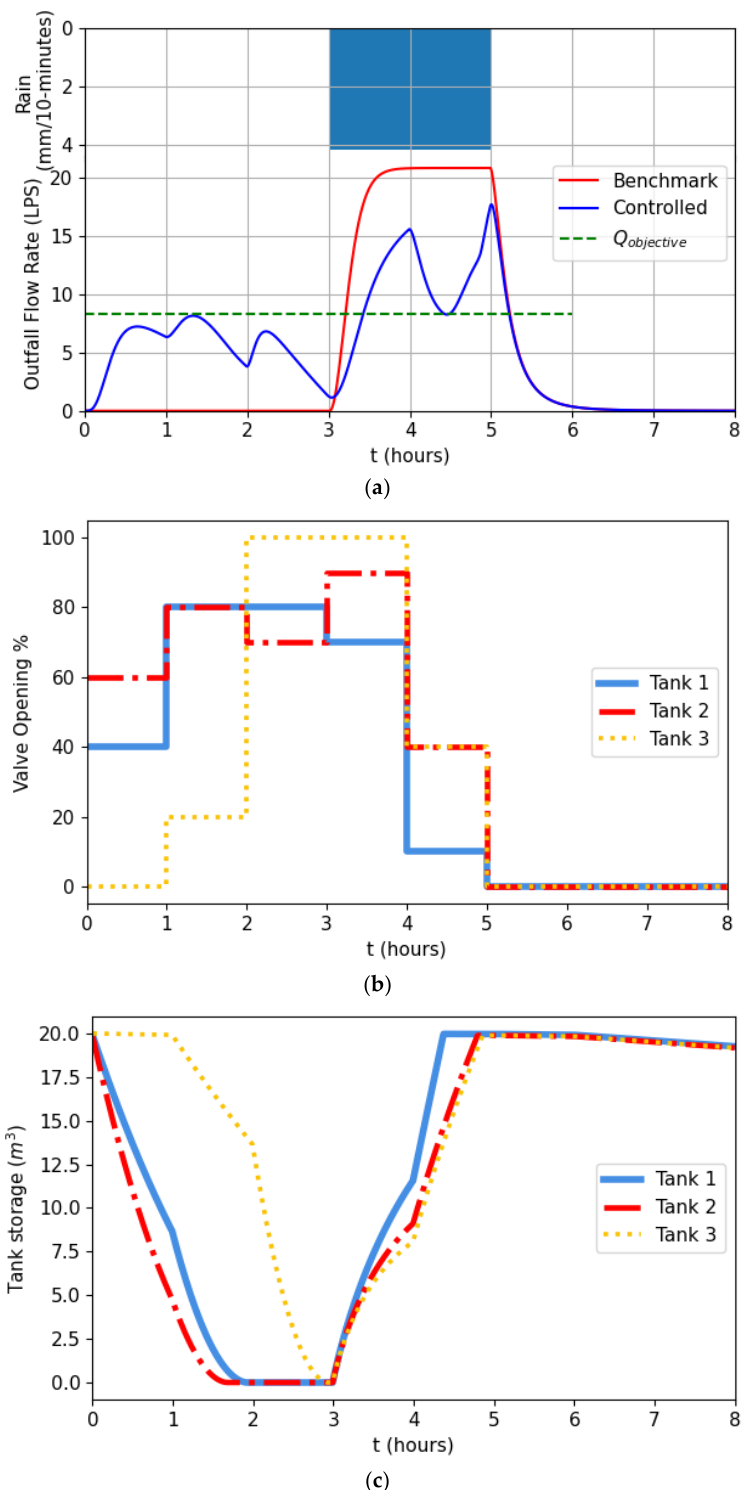
Figure 4. Results of applying the optimization process on a 2-h constant rain event of 5% probability. ( a ) Flow pattern of benchmark run (no controlled releases—red) and the optimized controlled release policy (blue). Q objective , which was used to evaluate the policy’s fitness according to Equation (5), is plotted in dashed green. ( b ) The control release policy, which was derived by applying the genetic algorithm—the degree of each valve’s opening during the simulated event. ( c ) Water stored in each tank during the simulated